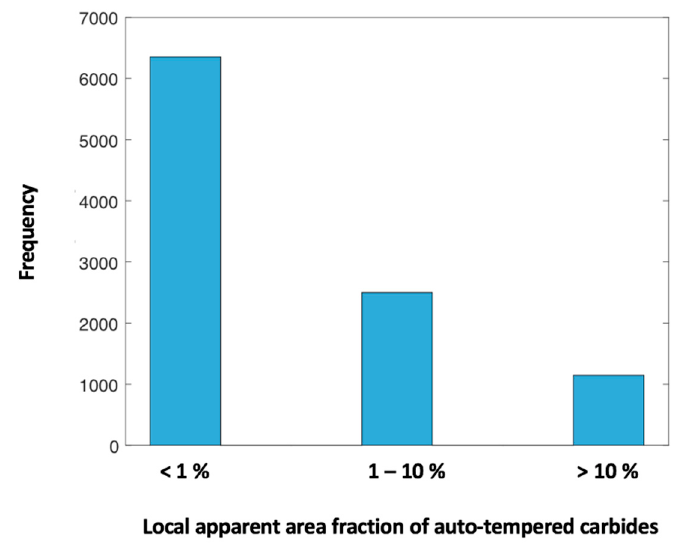
Figure 7. Histogram showing the distribution of local area fractions of auto-tempered carbides.